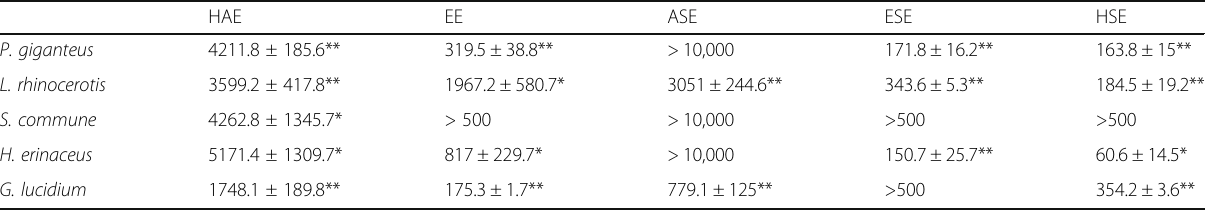
Table 3 Cytotoxic effects of the mushroom extract in Vero cells HAE